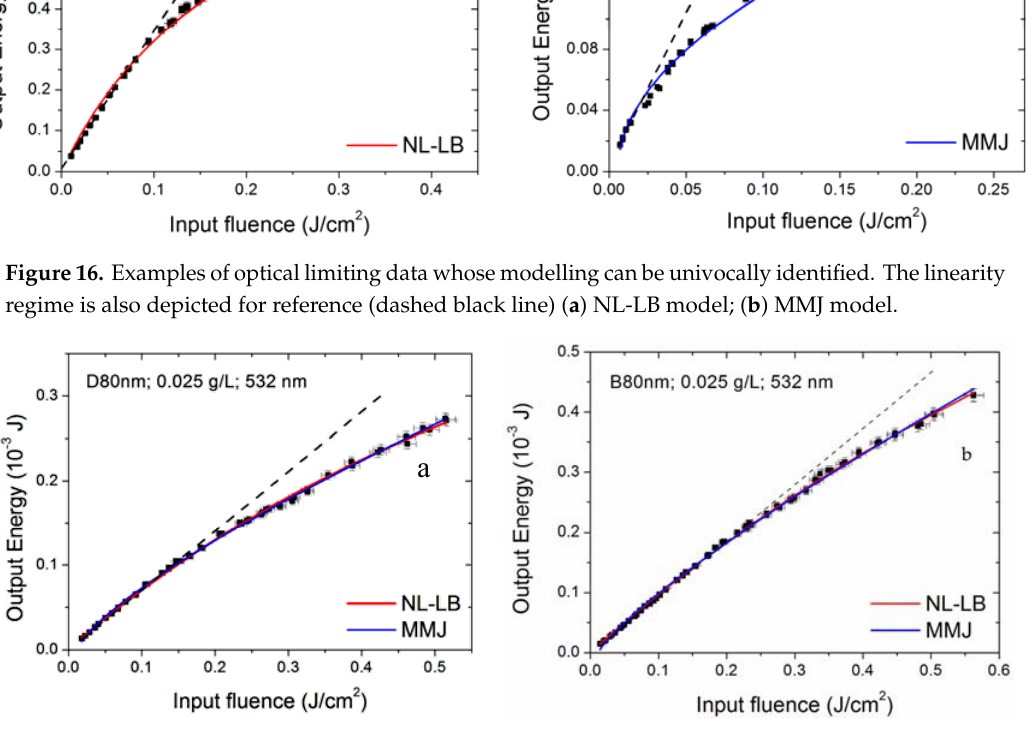
Figure 17. ( a , b ) Examples of optical limiting data allowing fitting by both models. The linearity regime (dashed black line) is also reported for enhanced visualization.